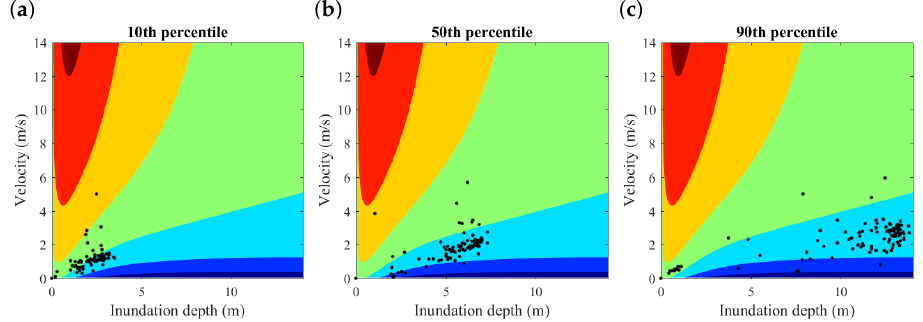
Figure 12. Distribution of inundation depth and flow velocity for RC structures of region R1 in Onagawa: ( a ) 10th percentile; ( b ) 50th percentile; and ( c ) 90th